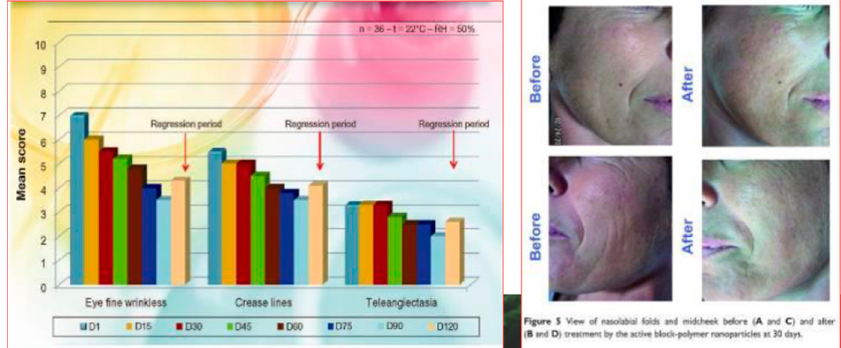
Figure 14. Anti-aging activity of chitin nanofibril [77].